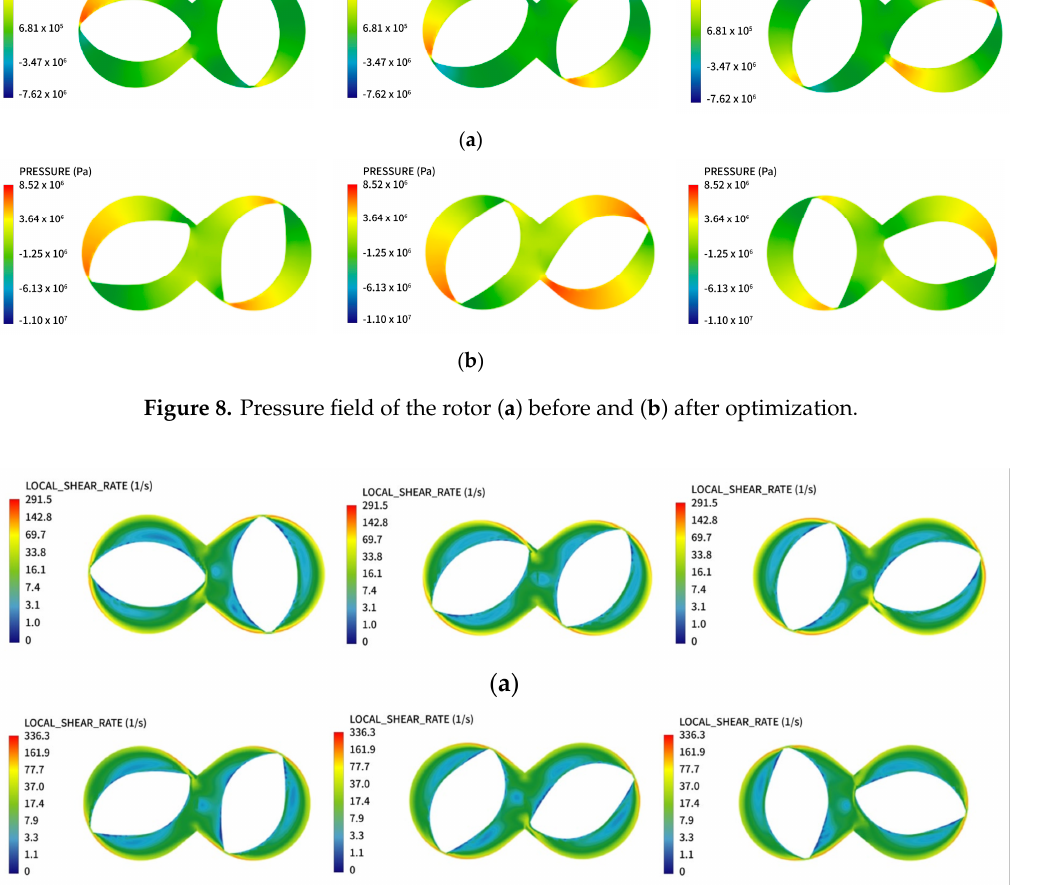
Figure 9. Shear rate field of the rotor ( a ) before and ( b ) after